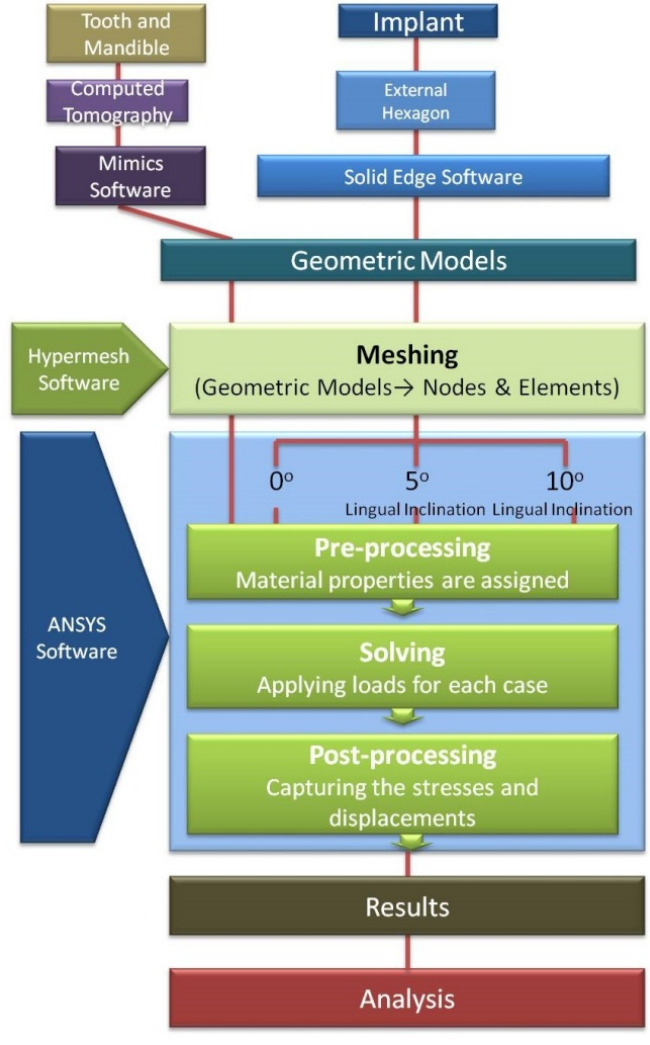
Figure 1. Flowchart of entire study.